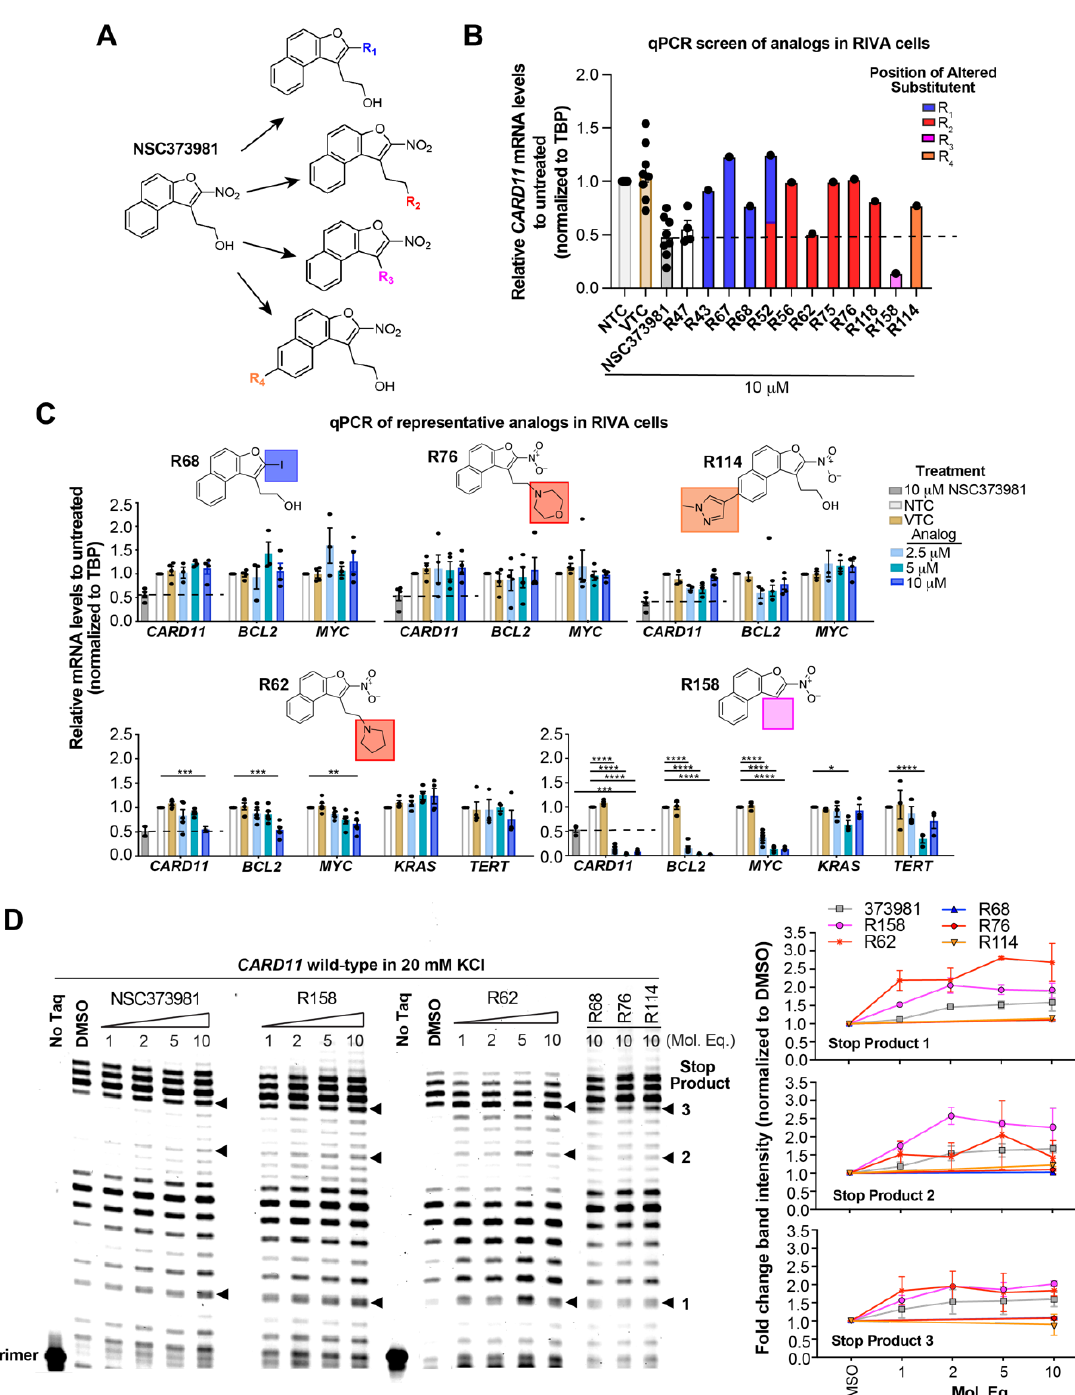
Figure 3. NSC373981 requires nitro-group for CARD11 G-quadruplex (G4) stabilization and repres- sion of CARD11 transcription. ( A ) Schematic depicting the NSC373981 parent compound structure and analogs generated to alter 4 different positions. ( B ) qPCR screen of 11 analogs in RIVA ABC diffuse large B cell lymphoma (DLBCL) cells following 24 h treatment. Untreated (NTC, no treatment control) and DMSO (VTC, vehicle treatment control)-treated cells served as controls. Data from controls represented as mean ± SE from 4 to 8 independent experiments. Data from 11 analogs represent a single experiment. ( C ) qPCR of RIVA cells treated for 24 h at increasing concentrations of the respective analog shown in the schematic with the specific altered substituent. NTC and VTC were used as negative controls and NSC373981 at 10 µM served as a positive control. Data repre- sented as mean ± SE from three independent experiments. ( D ) Representative DNA polymerase stop assay gel of two independent experiments (see Supplementary Figure S12 for replicate gel) With the quantification of band intensities of the CARD11 wild-type sequence in the presence of